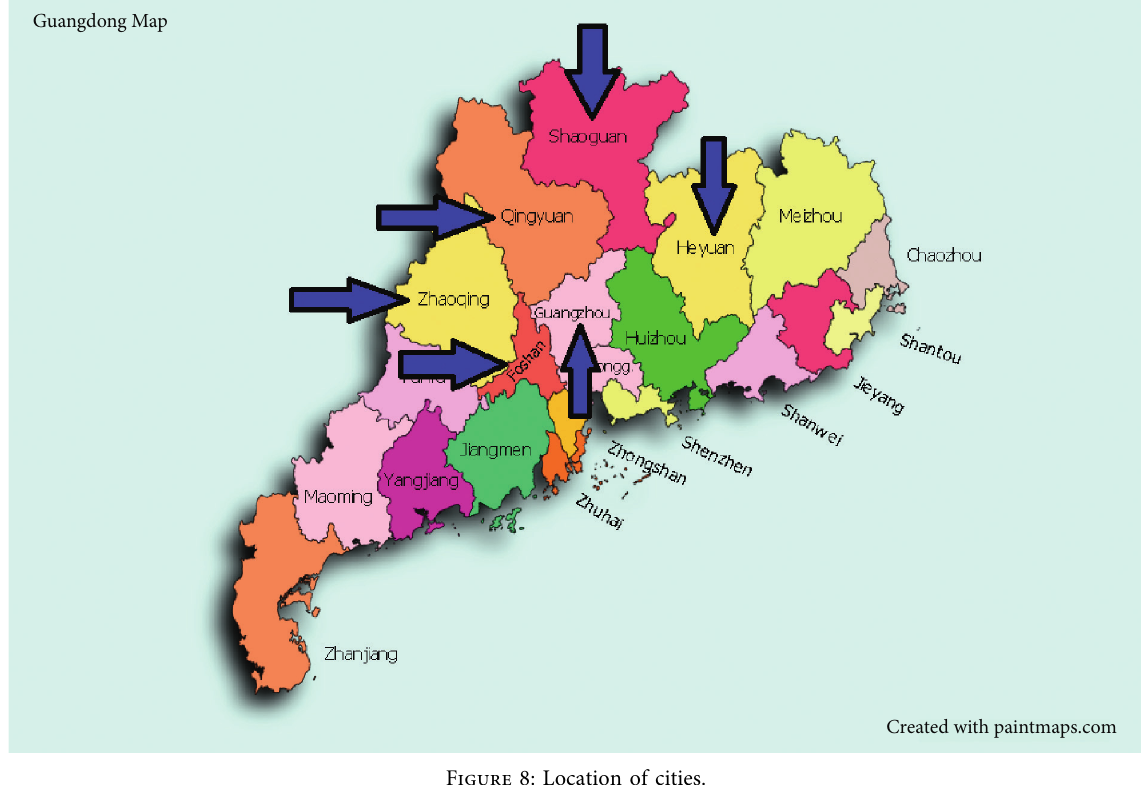
Figure 8: Location of cities.